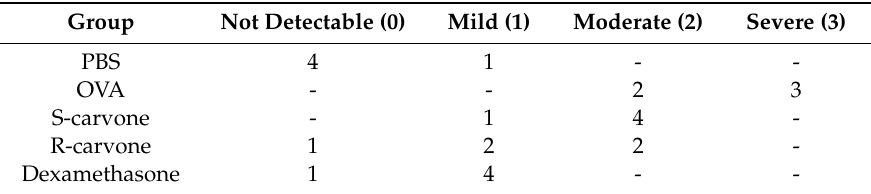
Figure 3. Effects of carvone enantiomers on leukocyte infiltration in the lung of allergic mice following OVA-induced allergic airway inflammation. Twenty-four hours after the last challenge, lungs were fixed in 10% formalin, embedded in paraffin and sectioned. The tissue section slides were stained with HE. OVA-sensitized mice were treated with R-carvone (10 mg/Kg), S-carvone (10 mg/Kg) or dexamethasone (1 mg/Kg) or saline (vehicle) 1 h prior to each challenge. These analyses were performed by a blind observer using a light microscope with 400× magnifications. Each photomicrograph is representative of two independent experiments performed with five animals per group. Table 1. Lung inflammation score per experimental group ( n = 5).